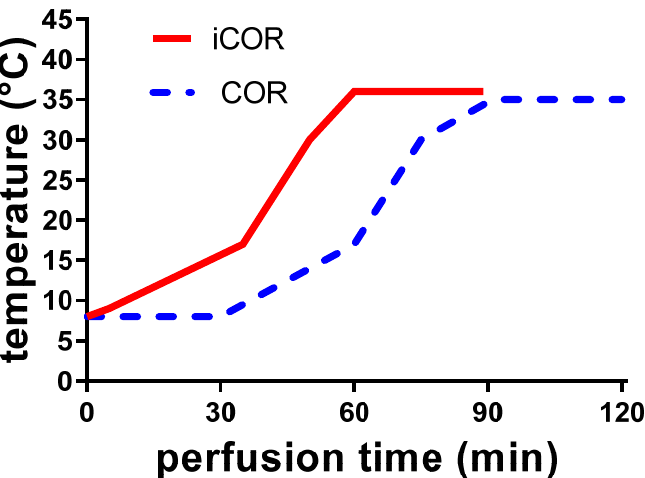
Figure 1. Representation of the thermal kinetic during controlled oxygenated rewarming by machine perfusion of porcine kidney grafts. Gentle rewarming of kidneys is either performed after an initial 30 min hypothermic equilibration period (COR, hatched line) or by starting the rewarming protocol immediately after connection to the machine (iCOR, continuous line).